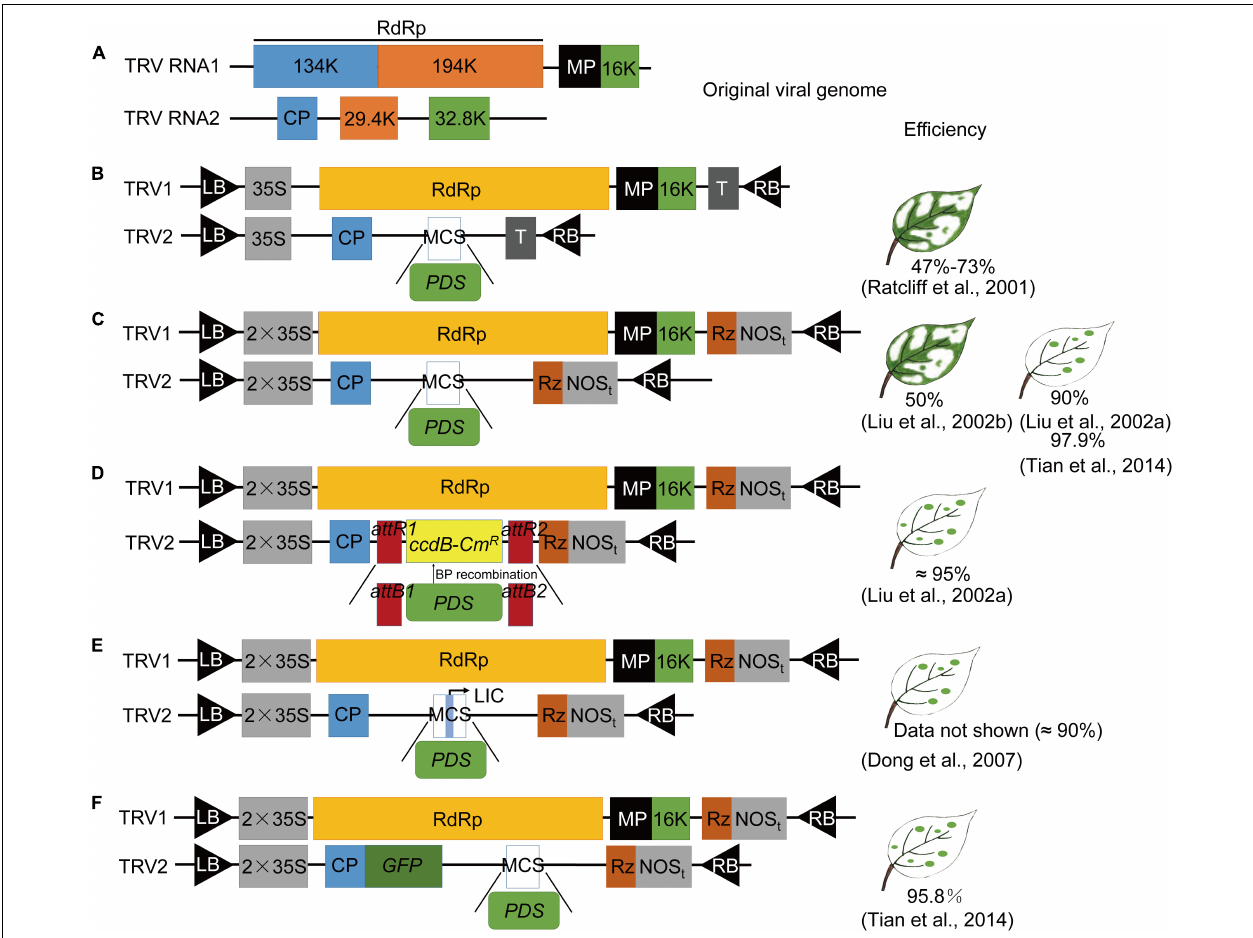
FIGURE 2 | The development process of TRV vector construction. Phytoene desaturase , PDS was used as an example. (A) Genome organization of tobacco rattle virus (TRV). The TRV1 open reading frames (ORFs) correspond to 134 and 194 kDa replicases, a movement protein (MP), and a 16 kDa cysteine-rich protein (16K). The TRV2 ORFs correspond to the coat protein (CP) and 29.4 and 32.8 kDa proteins (29.4K and 32.8K). (B) TRV-based VIGS vector (Ratcliff et al., 2001). Ratcliff et al. constructed separate cDNA clones of TRV (strain PPK20) RNA1 and RNA2 under the control of cauliflower mosaic virus (CaMV) 35S promoters on the transferred (T) DNA of plant binary transformation vectors. They replaced the non-essential 29.4K and 32.8K genes with a multiple cloning site (MCS), leaving only the 5 (cid:48) and 3 (cid:48) untranslated regions and the viral coat protein. The cDNA clones were positioned between the left and right border (LB and RB) of the T-DNA and between CaMV 35S promoters (35S) and transcriptional terminators (T). The TRV open reading frames corresponded to the RdRp, MP, 16K, CP, and 29.4K and 32.8K proteins. (C) TRV-based VIGS vector (Liu et al., 2002a,b; Tian et al., 2014). TRV1: TRV cDNA clones were placed between the duplicated CaMV 35S promoter (2 × 35S) and the nopaline synthase terminator (NOS t ) in a T-DNA vector. Rz, self-cleaving ribozyme. TRV2: TRV cDNA clones were placed between the duplicated CaMV 35S promoter (2 × 35S) and the nopaline synthase terminator (NOS t ) in a T-DNA vector, and PDS was added to the MCS between CP and Rz. (D) Modified pTRV2 vector based on GATEWAY cloning technology containing attR1 and attR2 recombination sites (Liu et al., 2002a). The PCR products flanked by attB1 and attB2 sequences directionally recombined in vitro at the attR1 and attR2 sites contained in the plasmid when incubated with the BP CLONASE enzyme. Then,